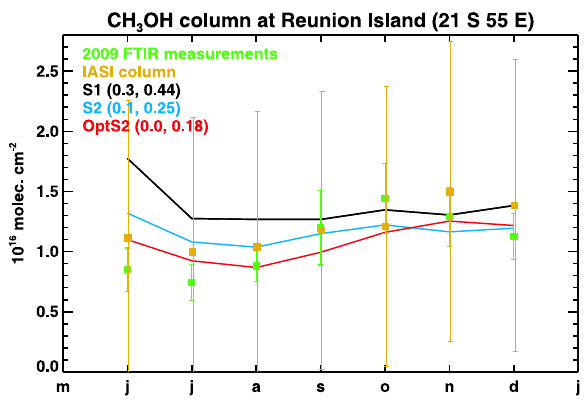
Fig. 11. Comparison between FTIR methanol columns at Reunion Island and model results from the S1 (in black) and S2 (in blue) a priori simulations and from the OptS2 simulation (in red), see Table 1. Green and orange error bars correspond to the standard deviation of FTIR measurements and the assumed error on IASI columns, respectively. The average model/FTIR bias and root mean square deviation are indicated inset in parentheses for each simulation.